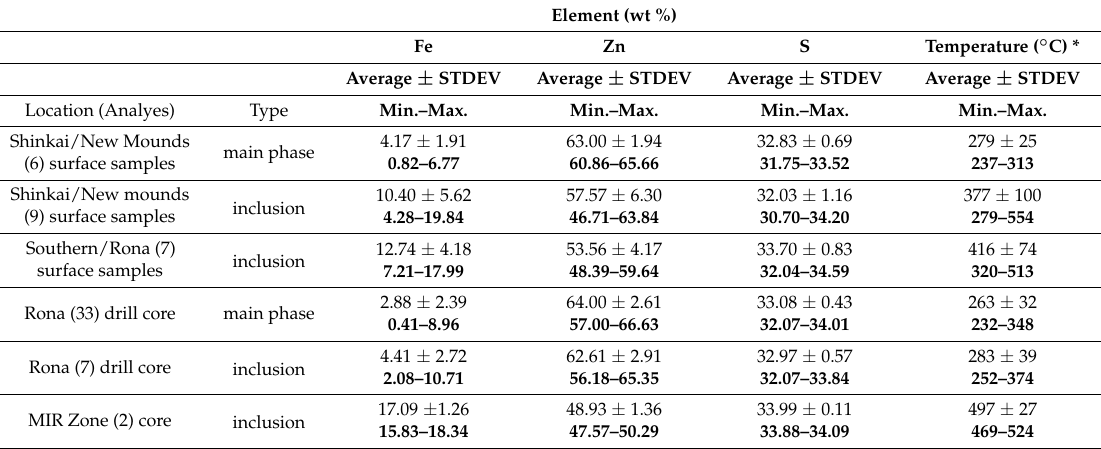
Table 1. Chemical composition of sphalerite from the TAG area obtained during Blue Mining cruise